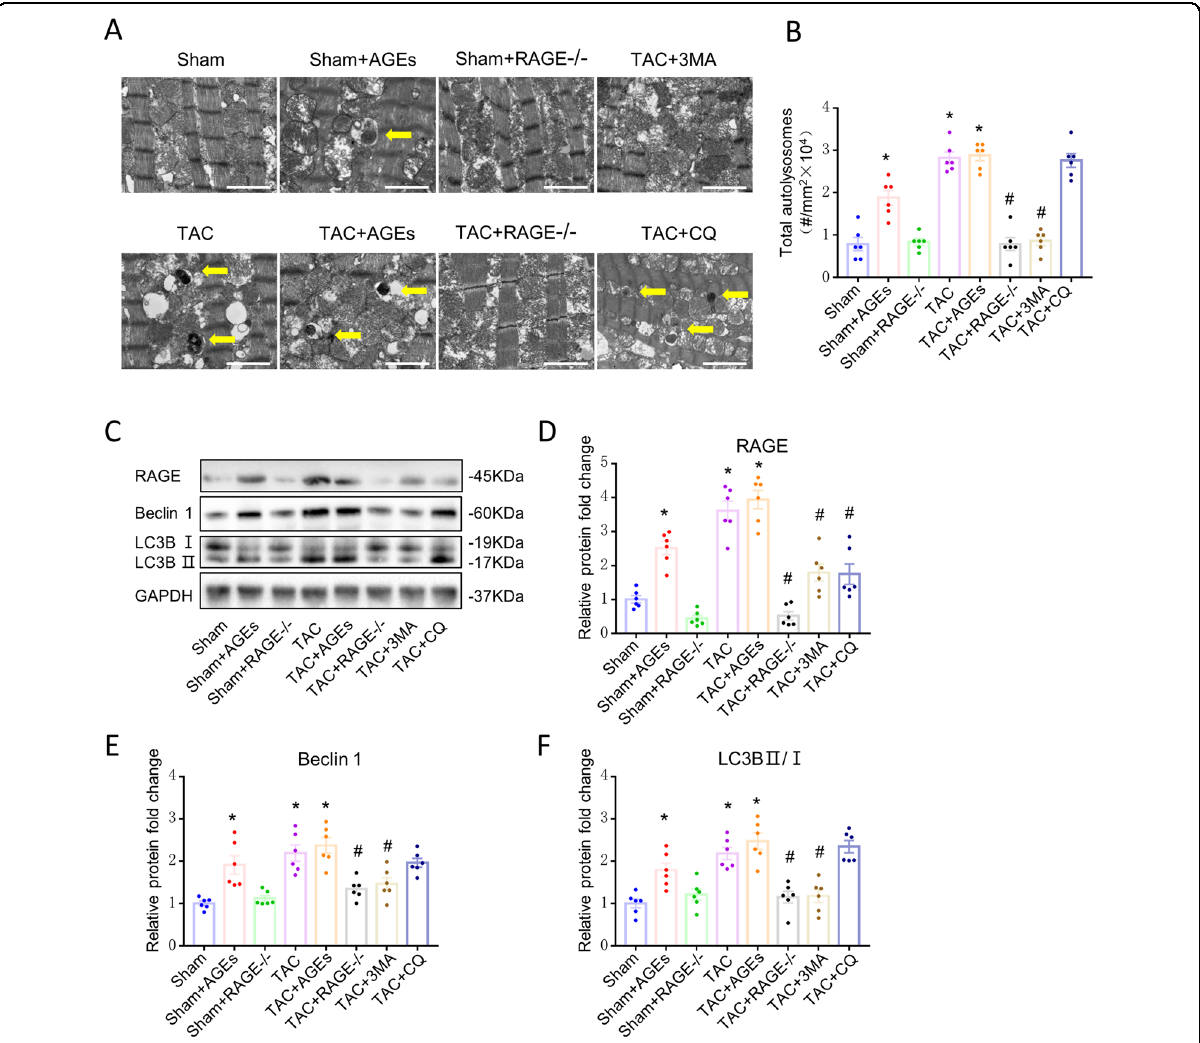
Fig. 5 Reduction of autophagy at 8 weeks after TAC by genetic deletion of RAGE or an autophagy inhibitor (3-MA or CQ). A Representative autophagic ultrastructure of the heart tissue under transmission electron microscopy (Scale bars = 2 µm; arrow: autolysosome). B Quanti fi cation of autophagy lysosomes analysis. C – F Left ventricular levels of RAGE and autophagy-related proteins (LC3BII/I and Beclin 1) were assessed by western blot. Quanti fi cation of RAGE ( D ), Beclin 1 ( E ), and LC3BII/I ( F ). GAPDH was used as the internal control. n = 6. Data are presented as mean ± SEM. * p < 0.05 vs. sham group, # p < 0.05 vs. TAC